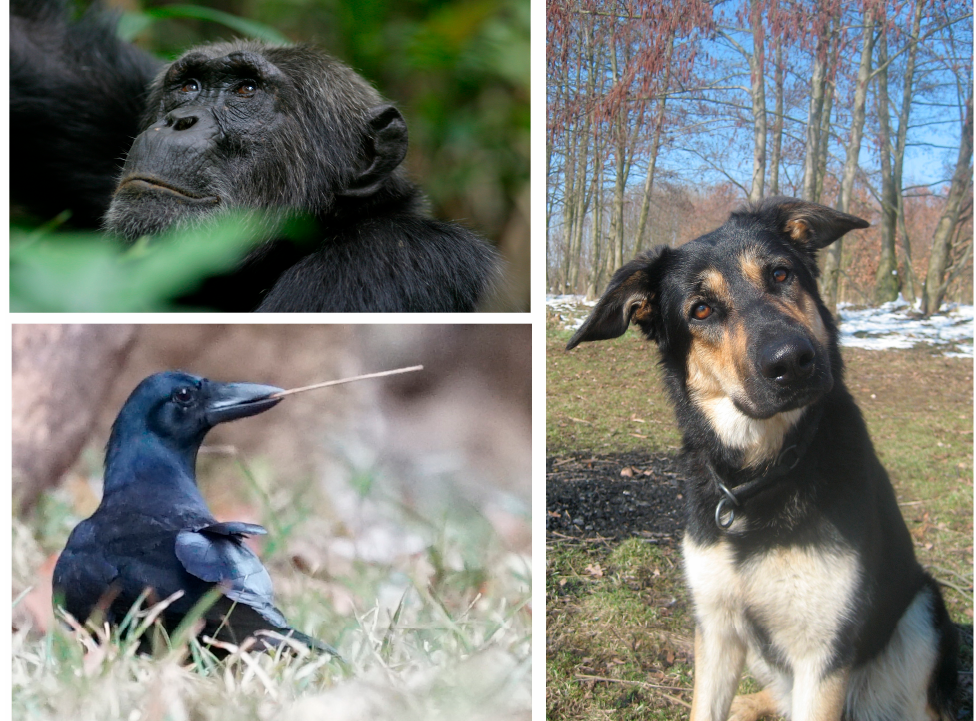
Figure 1. Clockwise from top left: chimpanzee, domestic dog, and New Caledonian crow participating in our research. Photographs by Simone Pika, Juliane Bräuer, and Natalie Uomini, respectively.